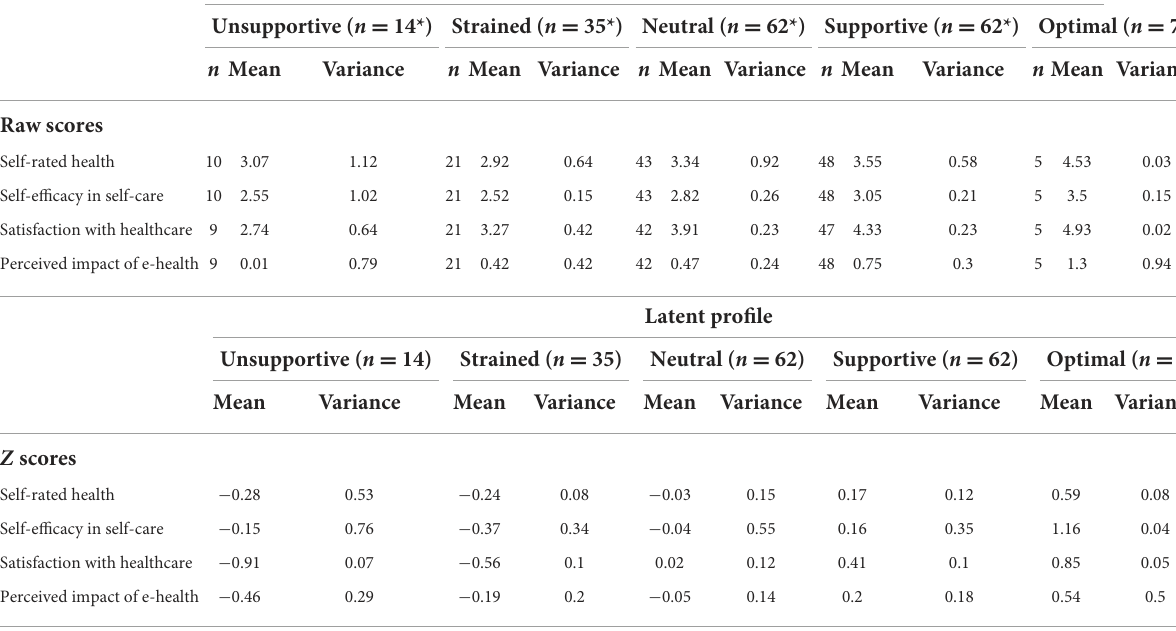
TABLE 9 Means and variances of the raw scores and z scores of exogenous variables at T2 ( N =